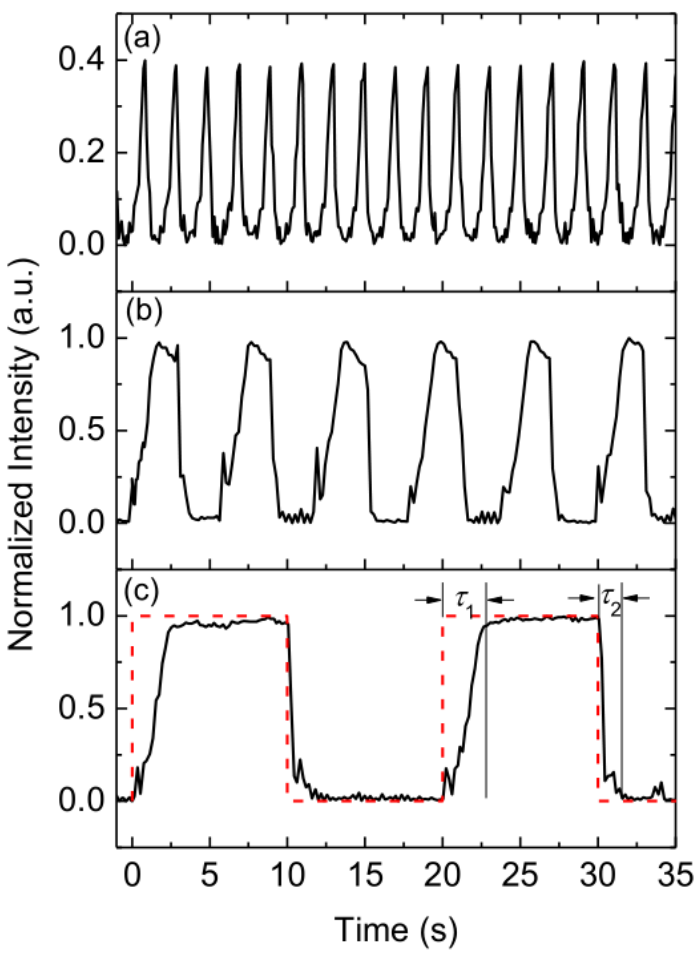
Figure 5. Detected signal with different switching periods: ( a ) 1 s, ( b ) 3 s, and ( c ) 10 s. τ 1 is the rising time and τ 2 is the falling time.